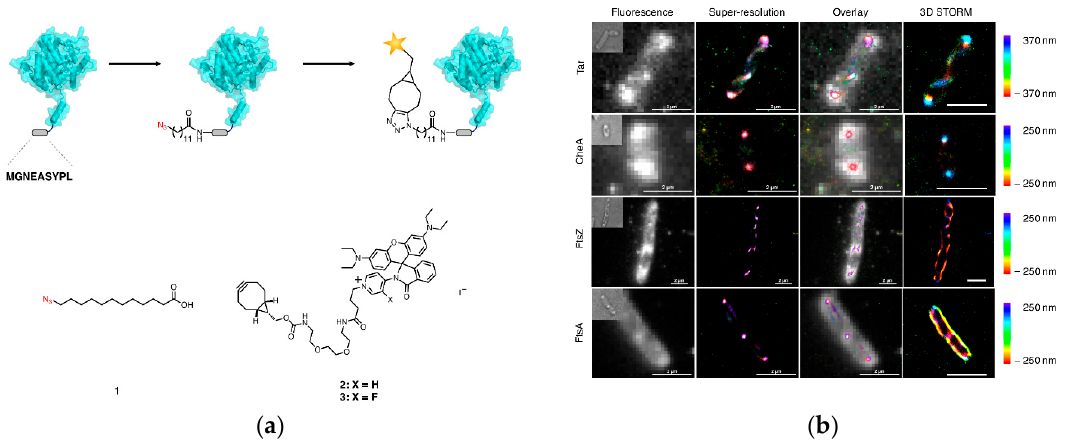
Figure 10. Protein labeling strategy: ( a ) A bacterial protein of interest is outfitted with a short N-terminal nonapeptide NMT recognition sequence (MGNEASYPL). Treatment of cells with 1 during the expression of the target protein results in the azide-labeled protein. Azide − alkyne cycloaddition with cell-permeant photo switchable dyes such as 2 and 3 tags the protein of interest for super-resolution imaging; ( b ) STORM images of bacterial proteins with polar localization (Tar and CheA) or septal localization (FtsZ and FtsA) expressed in E. coli . Adapted with permission from [152]. Further permissions related to the material excerpted should be directed to the ACS. Scale bars = 2 µm.